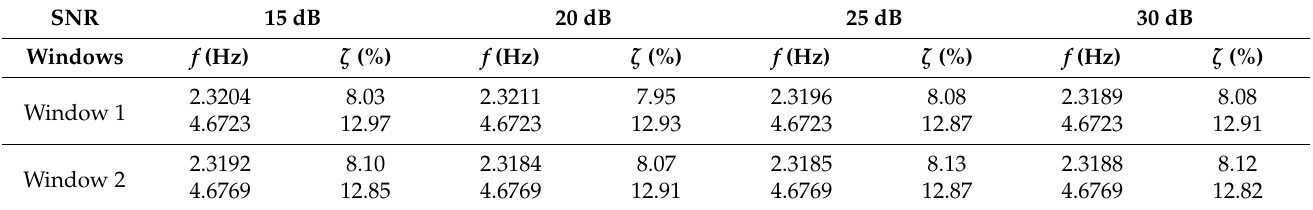
Table 6. Frequencies and damping ratios under different intensities of noise of Beishatan Bridge using the improved Data-SSI method.